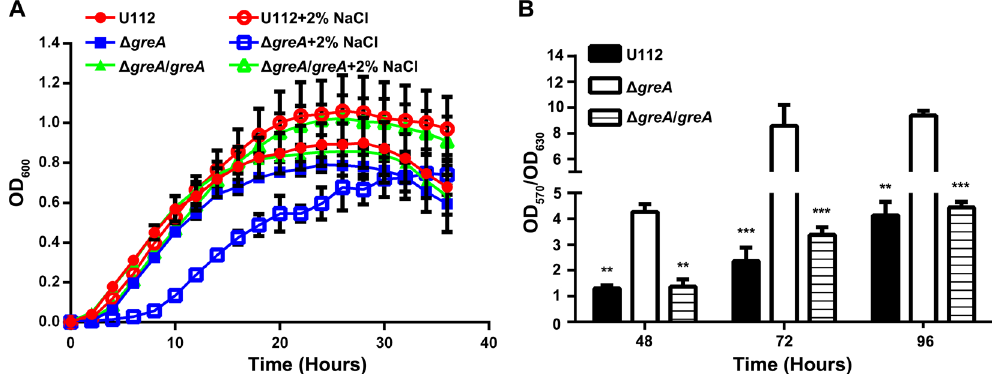
Figure 3. Bacterial stress tolerance and biofilm formation. ( A ) Growth kinetics of wild-type strain U112 and its derivatives in TSB with or without 2% NaCl. The values represent the means ± SD (n = 3) from one of the three independent experiments. ( B ) Biofilm formation by wild-type strain U112 and its derivatives in TSB in 96-well plates. Results are shown as OD 570 /OD 600 . The values were the means ± SD of the results from triplicate